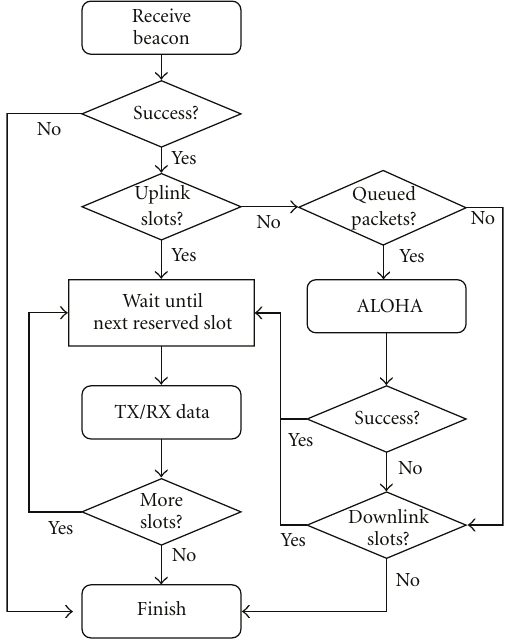
Figure 3: Operation of member node during a superframe. contention slots is minimized by piggybacking bandwidth adjustment signaling in data frames. Third, the number of contention slots is dynamically adjusted according load [41].